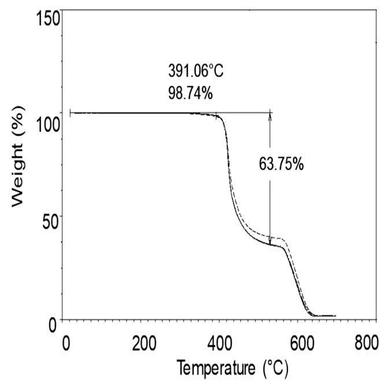
TMA results showing the degradation temperature and mass loss of RS-3C.